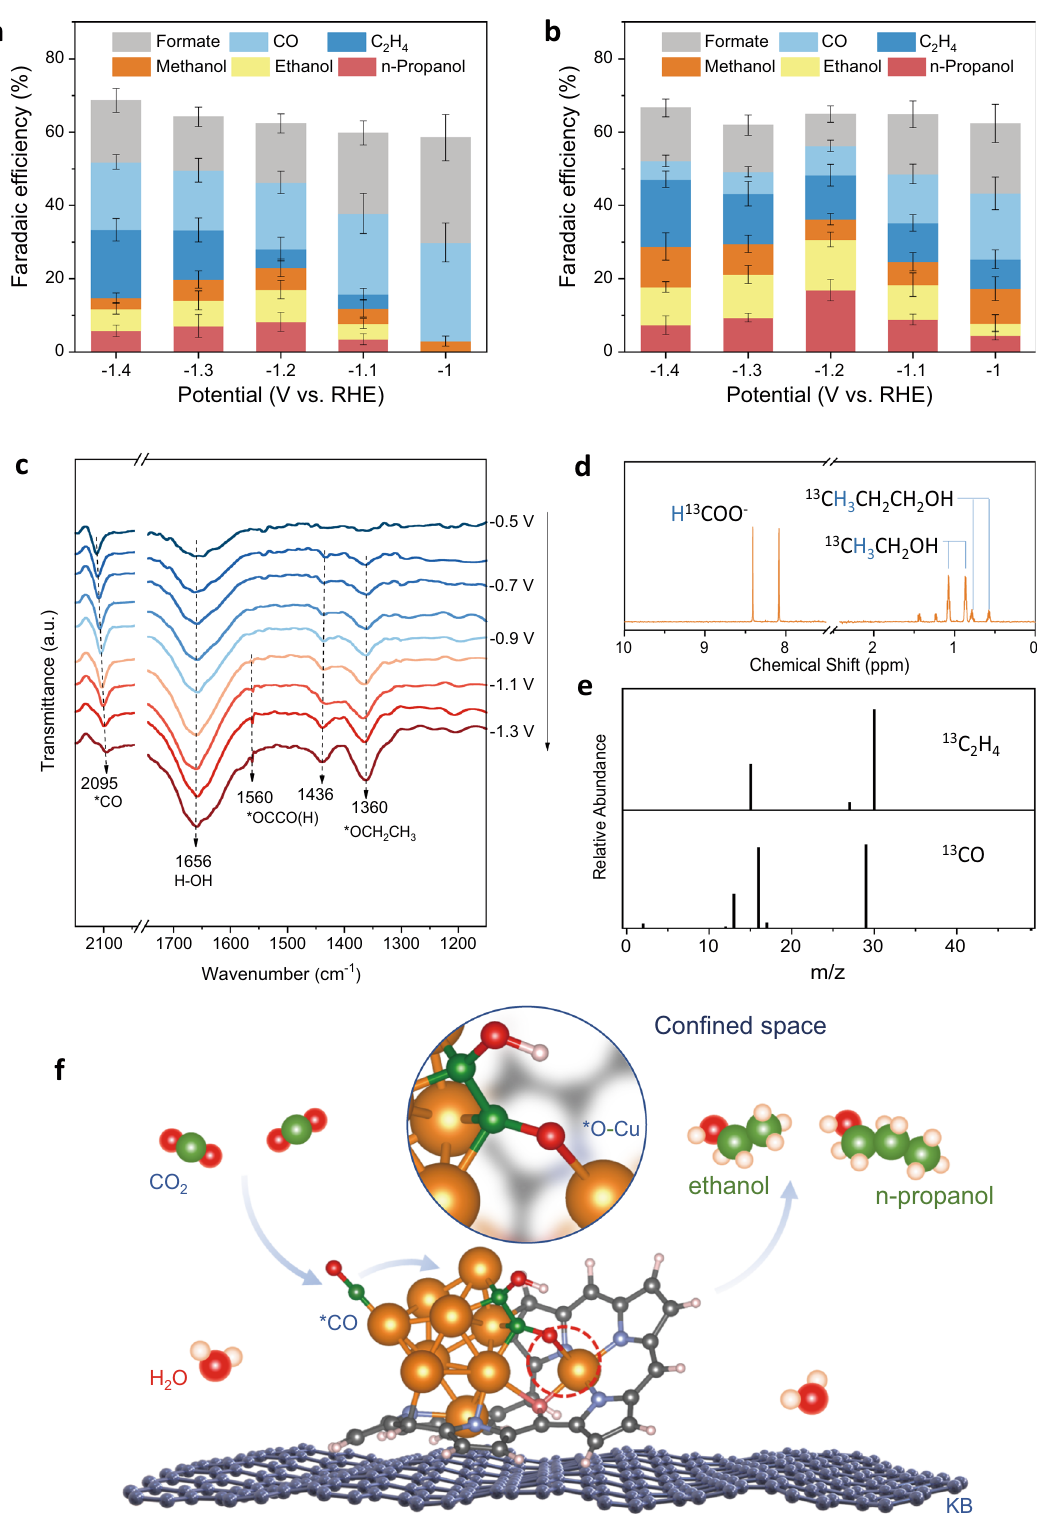
Fig. 4 | Mechanistic investigations into the alcohol production by Hex-2Cu-O. a , b CO 2 RR product distribution and the corresponding FEs at different potential for a Cu clusters remained on the electrode after ethanol soaking to remove the organic phase and b the mixtureof Cu-clusters/Hexaphyrins after casting backthe solute. c Operando ATR-SEIRAS spectra taken by ramping down the applied potentialfrom − 0.5to − 1.3VinCO 2 -saturated 0.1MKHCO 3 . d 1 H-NMR spectrum of